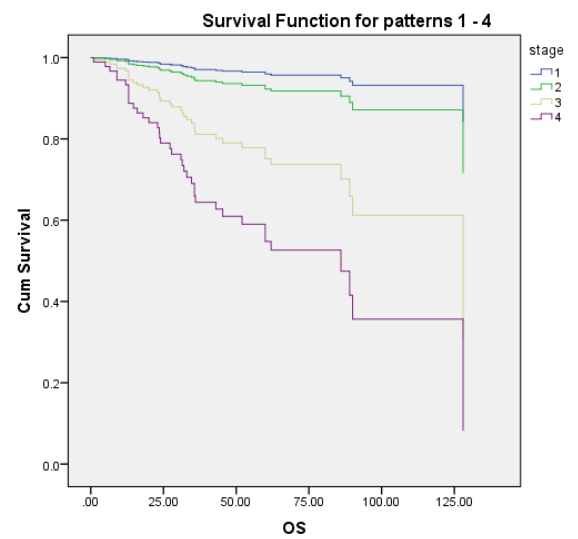
Table 2. Clinical and treatment outcomes in breast cancer patients Outcome No. of Patients